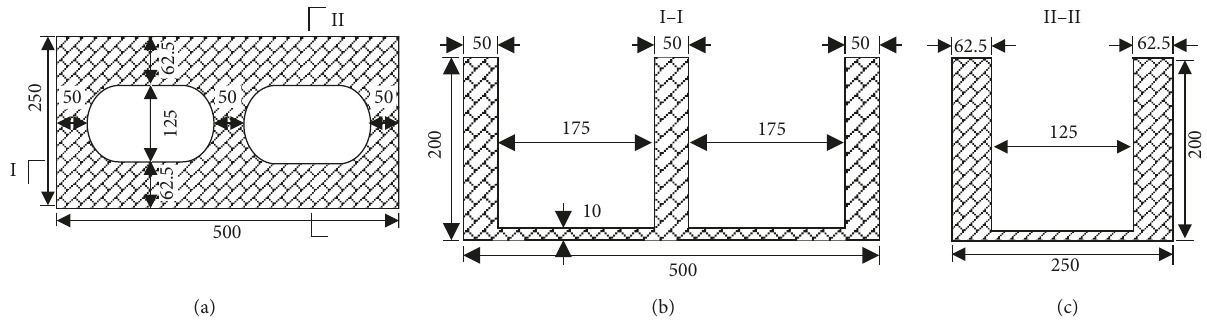
Figure 9: Block structural design. (a) Top view, (b) I cross section, and (c) II cross section.